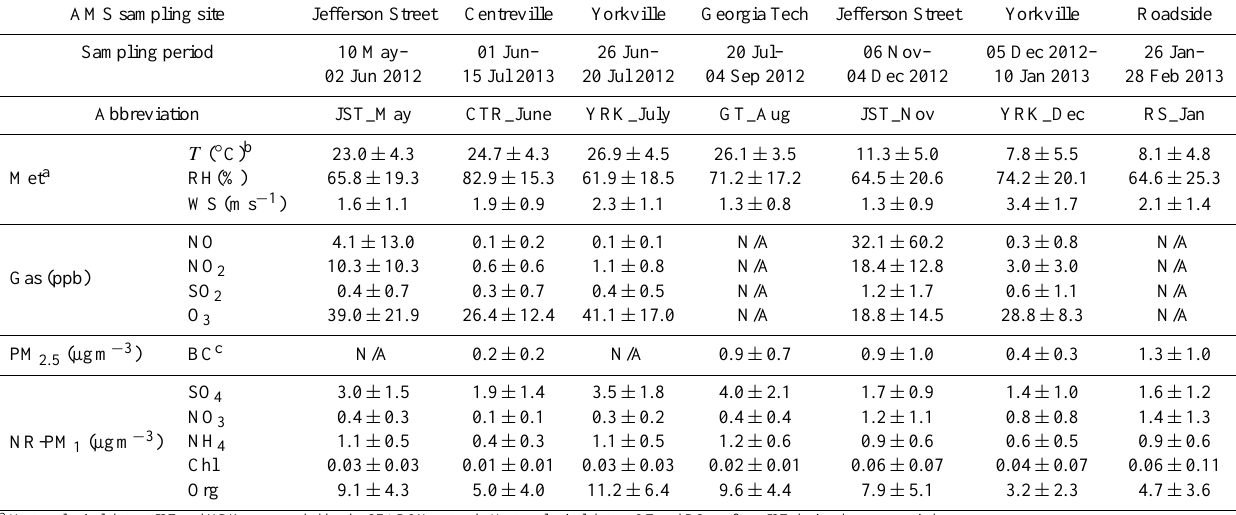
Table 1. Sampling sites and periods for the SCAPE and SOAS studies. Campaign average meteorological conditions, mixing ratios of gas- phase species, and mass concentrations of black carbon and NR-PM 1 species for all data sets. Average ± 1 standard deviation is